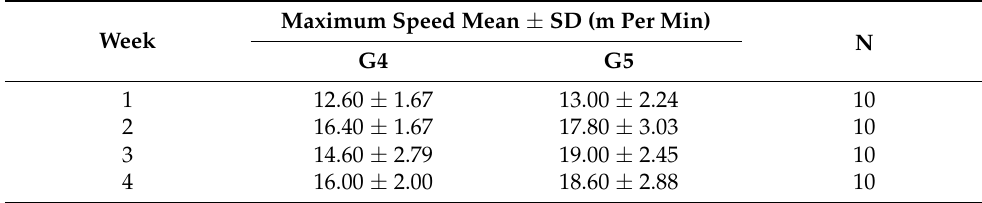
Table 4. The maximum speed evaluation over 4 weeks of treadmill training in G4 and G5 groups. Maximum Speed Mean ± SD (m Per Week